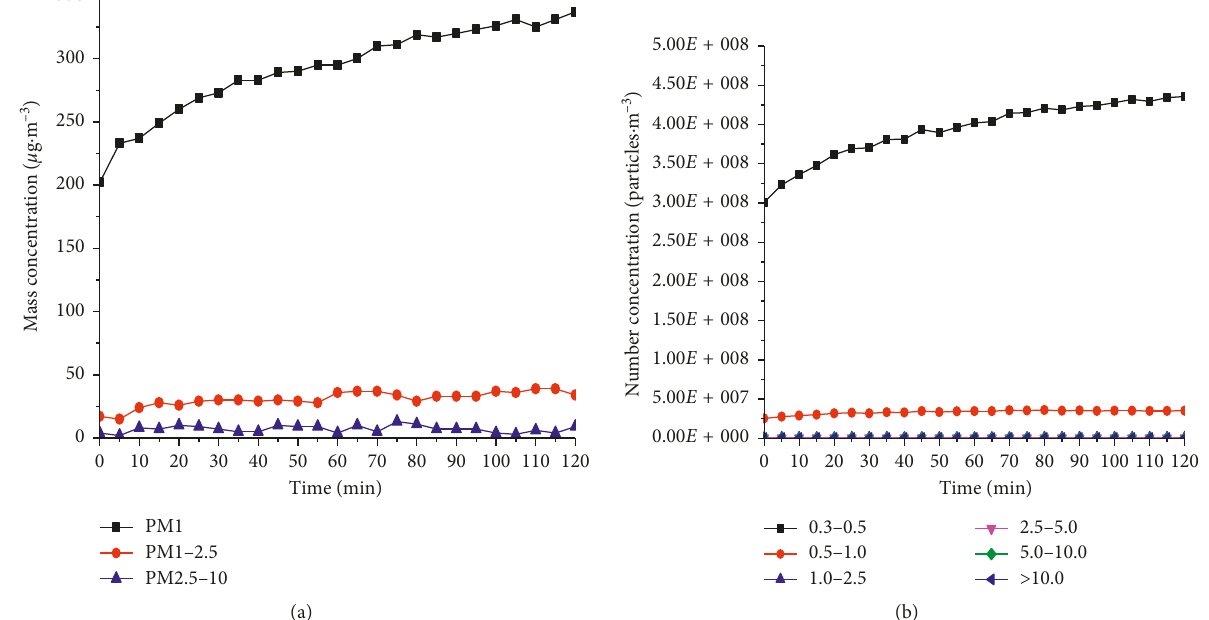
Figure 6: The indoor particle concentration in outdoor PM10 � 600–700 μ g · m − 3 : (a) mass concentration; (b) number